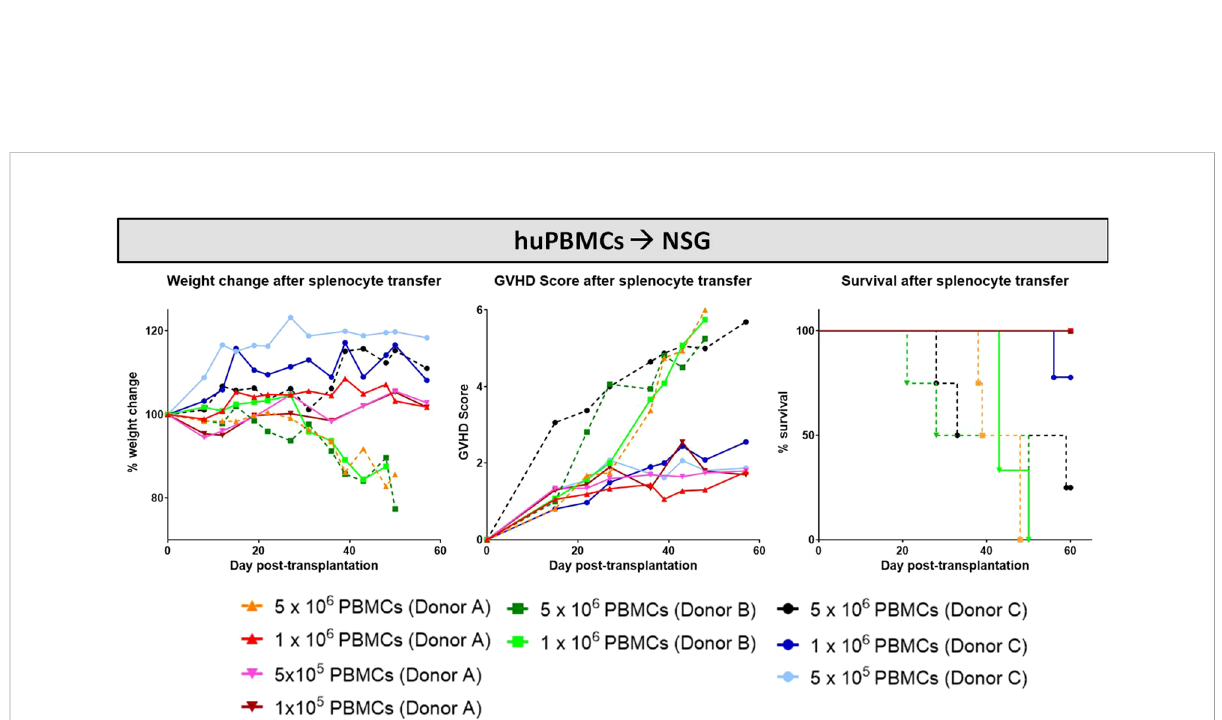
FIGURE 12 HuPBMC dose titration from three different donors for establishment of xeno-cGvHD in NSG-recipients over 60 days. Four different cell doses (5x106, 1x106, 5x105 and 1x105) from three different donors were transplanted into sub-lethally irradiated NSG. Clinical GvHD was estimated by weight change (left), GvHD score (middle) and survival (right). Animals were regularly scored for fi ve clinical parameters (weight loss, posture, activity, fur and skin) on a scale from 0 to 2. Clinical GvHD score was summarized of all fi ve parameters. A high variance in weight change and GvHD scores was observed not only between the cell doses, but among donors. Dotted lines indicate highest cell